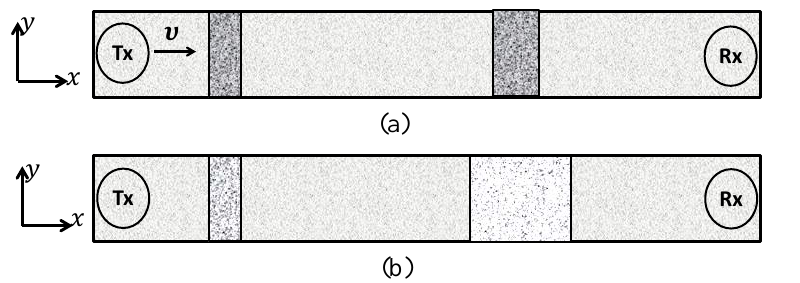
Figure 2. Propagation of the concentration signal from the transmitter (Tx) to the receiver (Rx) through the microfluidic channel based on the convection ( a ) and the diffusion ( b ).